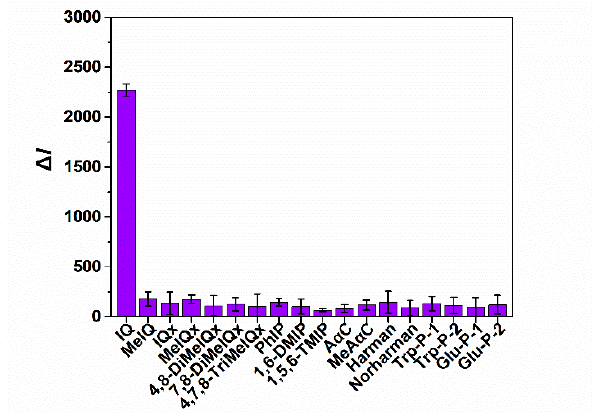
Figure 6. Specificity analysis of the fluorescence immunoassay. Each value is mean of three replicates. (2-amino-3-methylimidazo [4,5-f] quinoline, (IQ); 2-amino-3,4-dimethylimidazo [4,5-f] quinoline (MeIQ); 2-amino-3-methylimidazo [4,5-f] quinoxaline (IQx); 2-amino-3,8-dimethylimidazo [4,5-f] quinoxaline (MeIQx); 2-amino-3,4,8-trimethylimidazo [4,5-f] quinoxaline (4,8-DiMeIQx); 2-amino-3,7,8-trimethylimidazo [4,5-f] quinoxaline (7,8-DiMeIQx); 2-amino-3,4,7,8-tetraimethylimidazo [4,5-f] quinoxaline (4,7,8-TriMeIQx); 2-amino-1-methyl-6-phenylimidazo [4,5-b] pyridine (PhIP); 2-amino-1,6-dimethylimidazo [4,5-b] pyridine (1,6-DMIP); 2-amino-1,5,6-trimethylimidazo [4,5-b] pyridine (1,5,6-TMIP); 2-amino-9H-pyrido [2,3-b] indole (A α C); 2-amino-3-methyl-9H-pyr-